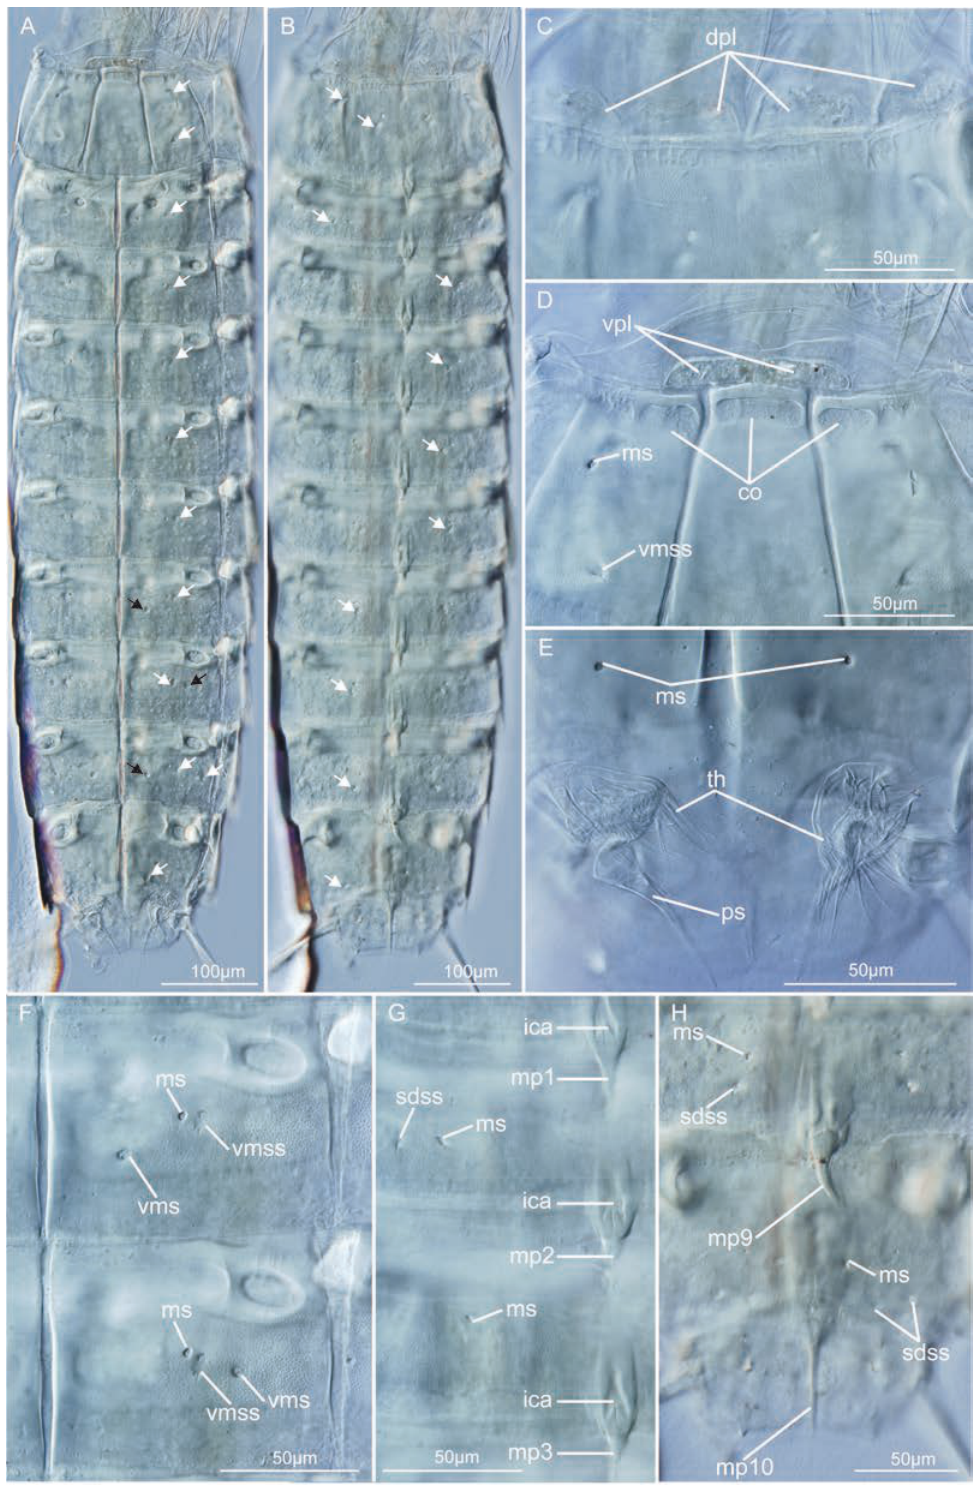
dorsal view of left half of segments 1-3; H, dorsal view of segments 9-11; co cuticular ornamentation, dpl dorsal placid, ica intracuticular atria of sensory spots, mp middorsal process, ms muscular scar, ps penile spine, sdss subdorsal sensory spot, th tuft of hairs, vms ventromedial seta, vmss ventromedial sensory spot, vpl ventral placid. Sensory spots are marked with white arrows. Setae are marked with black arrows. Digits following labels refer to segment